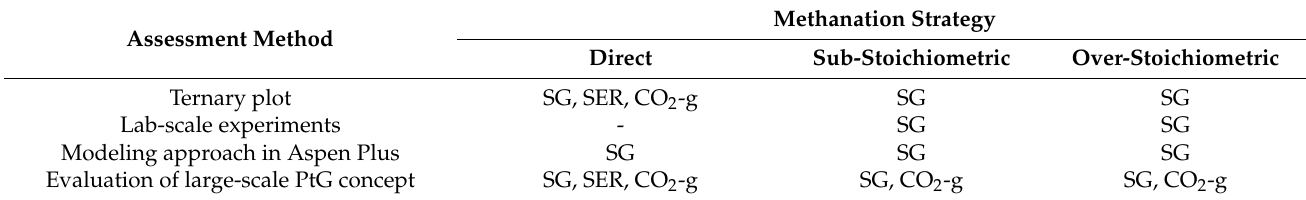
Table 4. Assessment methodology matrix showing technical figure evaluation tools applied on different methanation strategies and syngas compositions (steam gasification = SG, SER, 100% CO 2 gasification = CO 2 -g or none (-)). Methanation Strategy Assessment Method Direct Sub-Stoichiometric Over-Stoichiometric Ternary plot SG, SER, CO 2 -g SG SG Lab-scale experiments - SG SG Modeling approach in Aspen Plus SG Evaluation of large-scale PtG